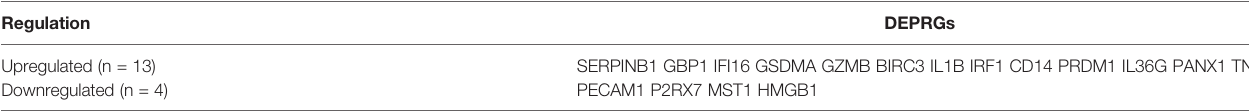
TABLE 2 | The DEPRGs of